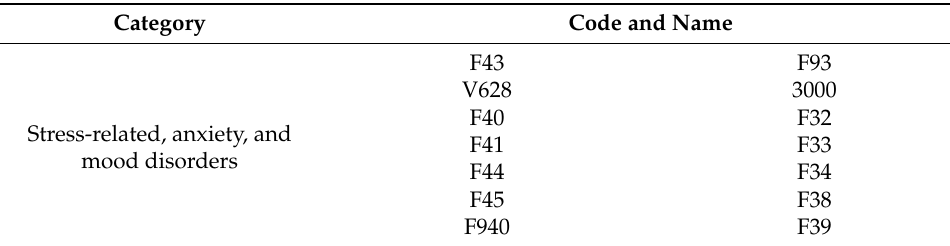
Table A1. Classification of diagnoses, by ICD-10 code